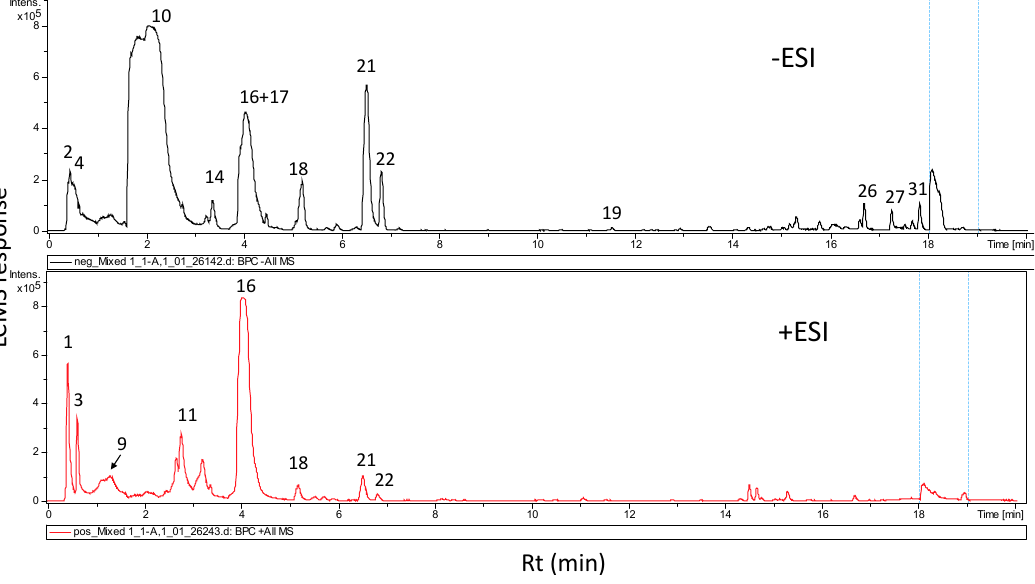
Figure 5. Representative UHPLC-MS base peak chromatogram of L. sativum 100% methanol seed extract in negative mode (black color) and positive (red color) ionization mode. Peak numbers follow those listed in Table 2. (Rt.: retention time).